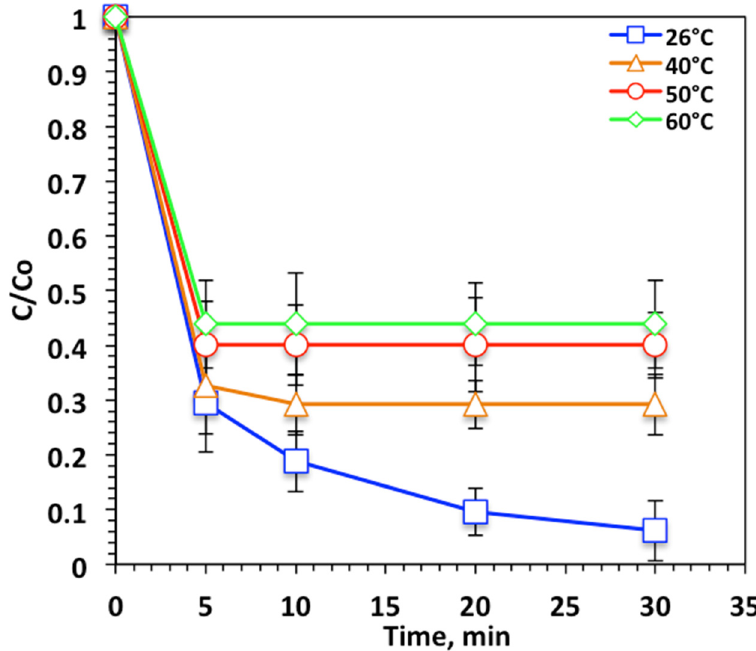
Figure 10. Effect of temperature on Nudrin removal by the photo-Fenton-like oxidation.